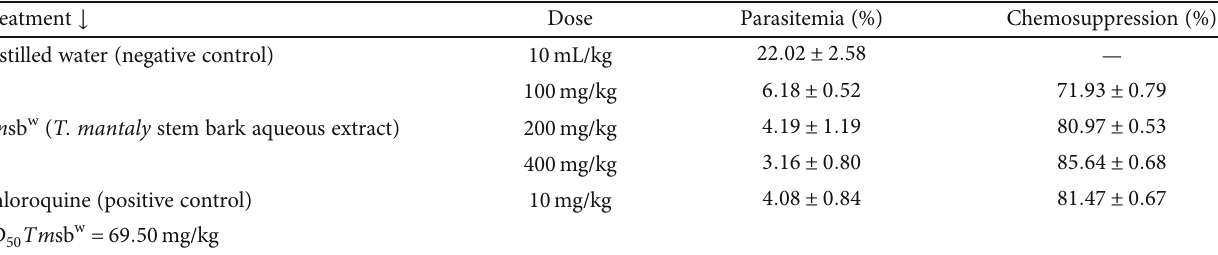
Table 2: Curative e ff ect of Tm sb w on P. berghei -infected mice. Treatment ↓ Dose Parasitemia (%) Chemosuppression (%) Distilled water (negative control) 10mL/kg 22 : 02 ± 2 :